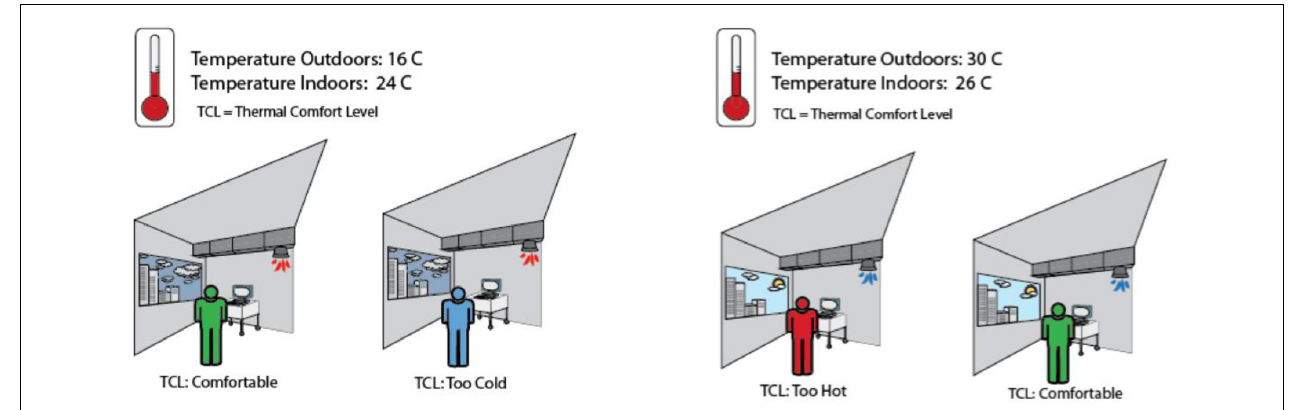
FIGURE 2 | Building occupants experience different thermal comfort preferences under similar environmental and physical